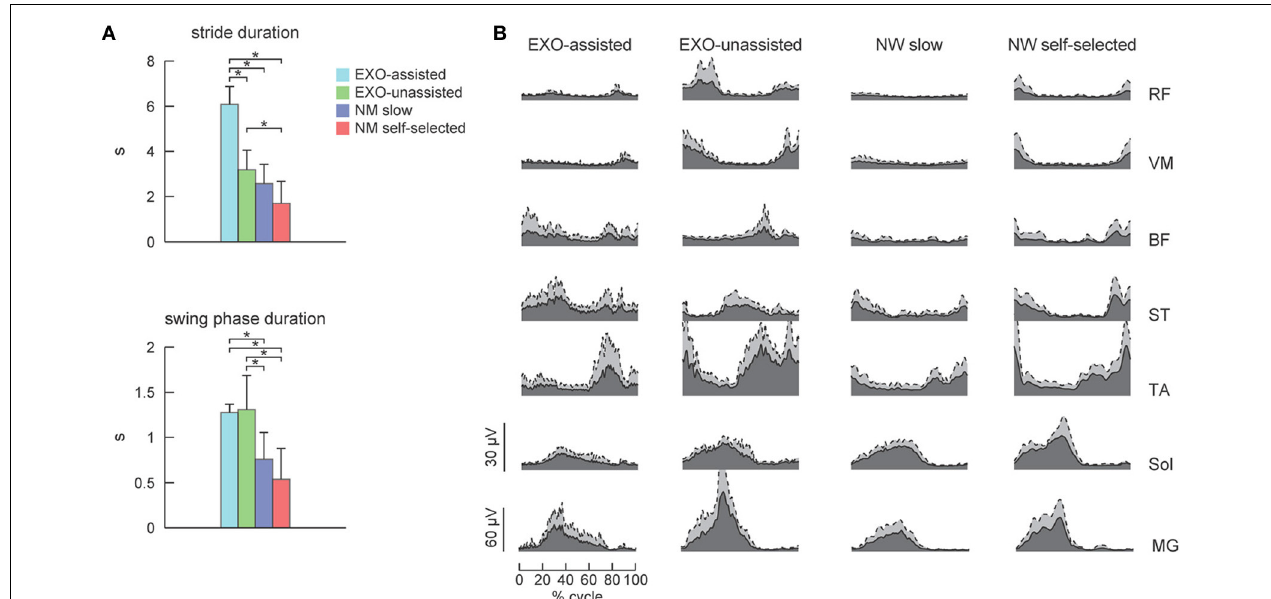
FIGURE 3 | EMG patterns in healthy subjects during walking in the exoskeleton and during normal overground walking. (A) Stride and swing durations (mean + SD , n = 6) for each experimental condition. (B)